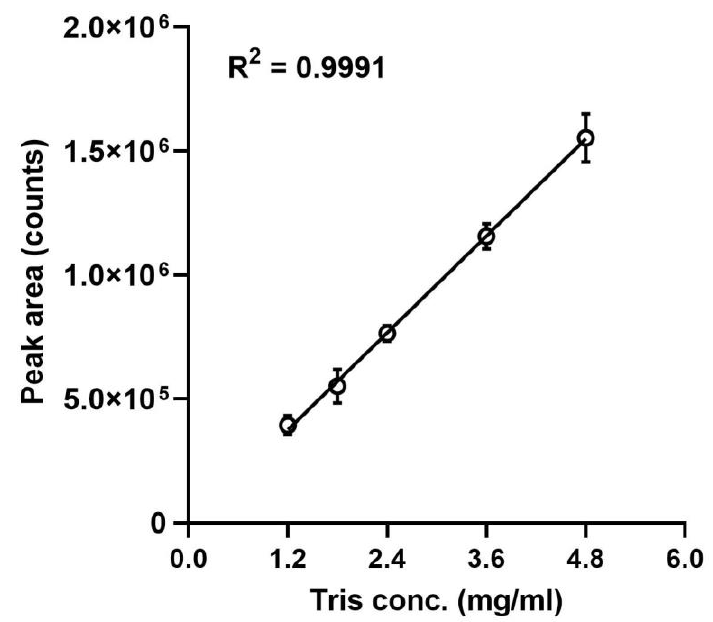
Figure 5. A five-point calibration curve. The peak areas were plotted against the TRIS-IBCF concentrations. The regression line was calculated for concentrations of triplicates of independent derivatizations of a standard TRIS solution. Error bars are ± 1 standard deviation.